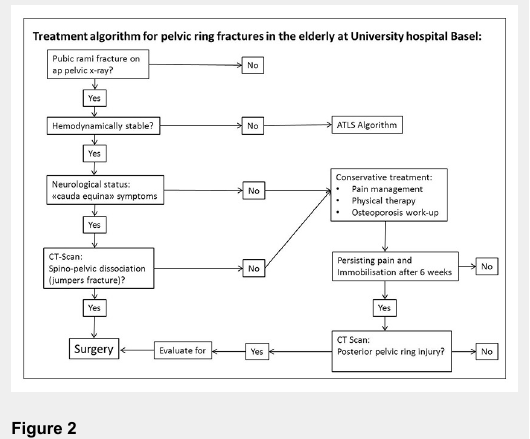
Currently used treatment algorithm for pelvic ring fractures in elderly patients.